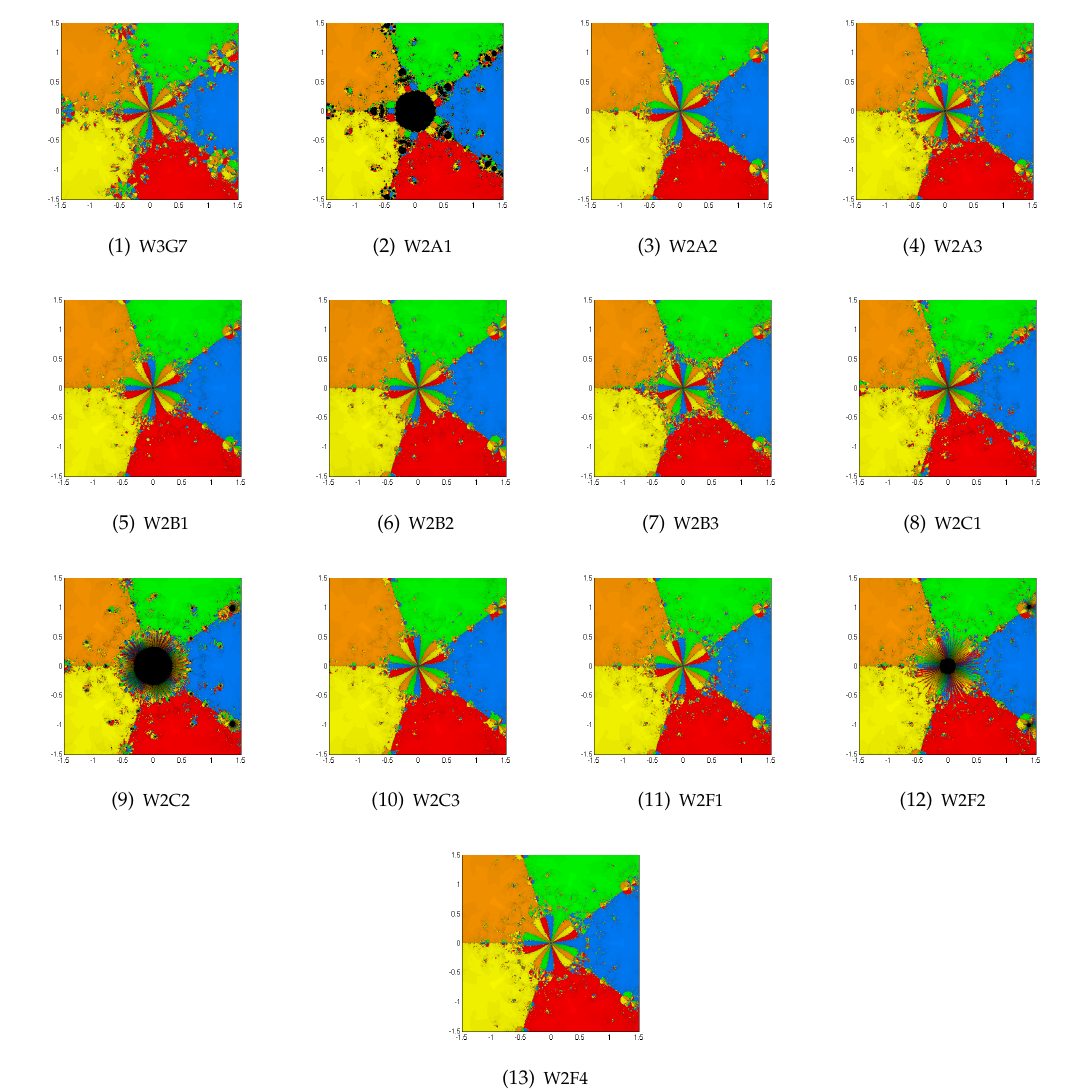
Figure 5. The top row for W3G7 ( left ), W2A1 ( center left ), W2A2 ( center right ) and W2A3 ( right ). The second row for W2B1 ( left ), W2B2 ( center left ), W2B3 ( center right ) and W2C1 ( right ). The third row for W2C2 ( left ), W2C3 ( center left ), W2F1 ( center right ) and W2F2 ( right ). The bottom row for W2F4 ( center ), for the roots of the polynomial equation ( z 5 − 1 ) 3